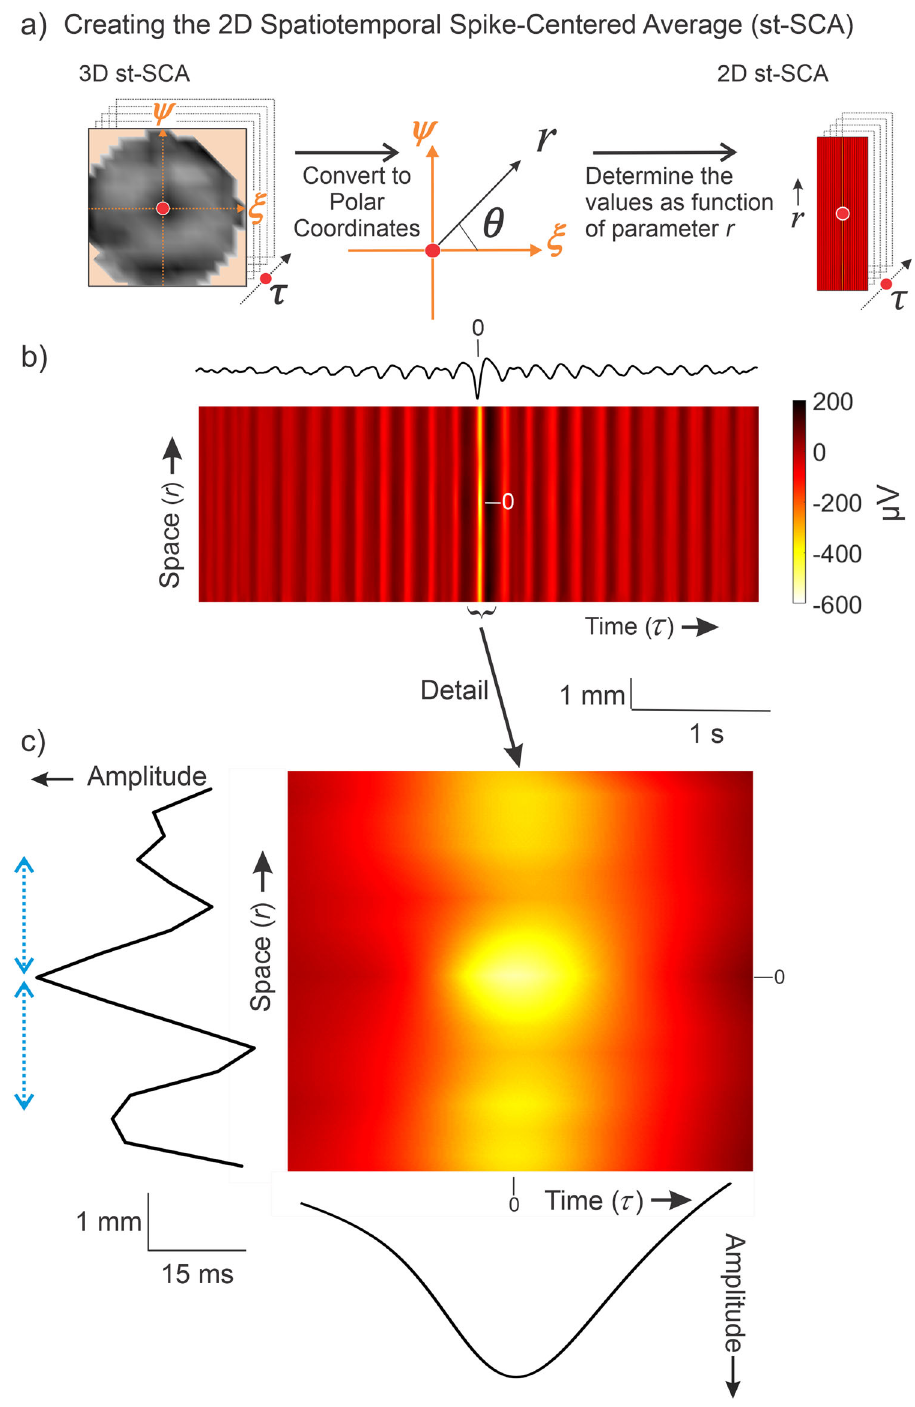
Fig. 5 The method to compute the 2D spatiotemporal spike-centered average, st-SCA( r , τ ) allows for a detailed visualization of spatial and temporal components for Patient 1. a The Cartesian coordinates ð ξ ; ψ Þ from the 3D st-SCA are converted into polar coordinates ð r ; θ Þ , resulting in a 2D st-SCA. b A color representation of st-SCA ð r ; τ Þ . The temporal component of the st-SCA ð τ Þ (black trace) is obtained by the sum of st-SCA r ; τ ð Þ over r (same as the signal in Fig. 4e). Amplitude and color scales are in μ V. c Detail of the central part of ( b ). The left margin shows the resulting wave from summation over time, generating the spatial component of st-SCA. The blue arrows on the left indicate the distance (~2.5 mm) between the peaks seen in this function. The bottom margin depicts the resulting wave from summation over space, generating the temporal component of the (Fig. 4e and Supplementary Fig. 2a – c). In turn, the ring of net excitation during seizures in all patients. The activity level in reduced excitation is surrounded by a second ring at an additional the excitatory center, representing the activity at the ictal wave, is distance of ~1 mm where excitation increases again. For these excessively high, possibly due to saturation of the local inhibitory patients, this donut-shaped st-SCA is speci fi c to the recruited population 17 . In Patients 1 – 3 we also observe a ring of reduced excitation at a distance ~1.5 mm around the excitatory center seizure territory in the ictal phase (Supplementary Figs. 2a – c